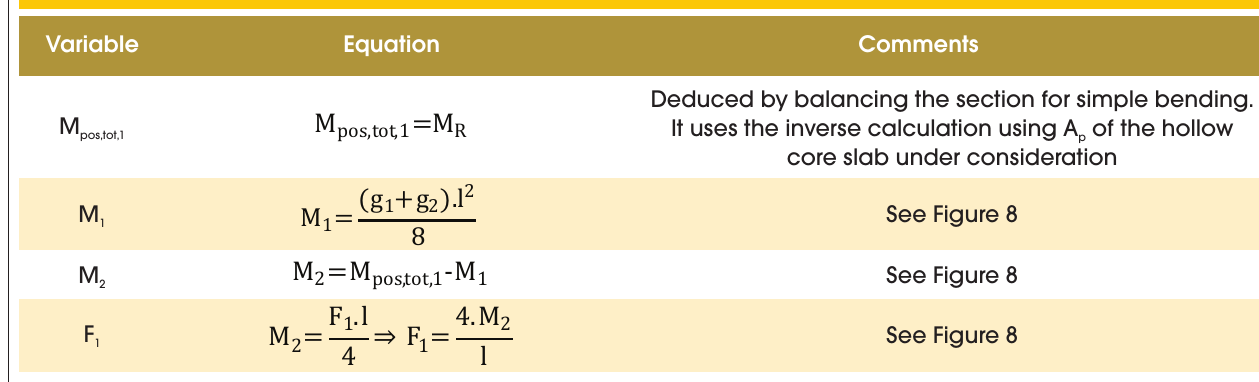
Table 2 – Equations for calculating of hollow core slabs simply supported Variable Equation